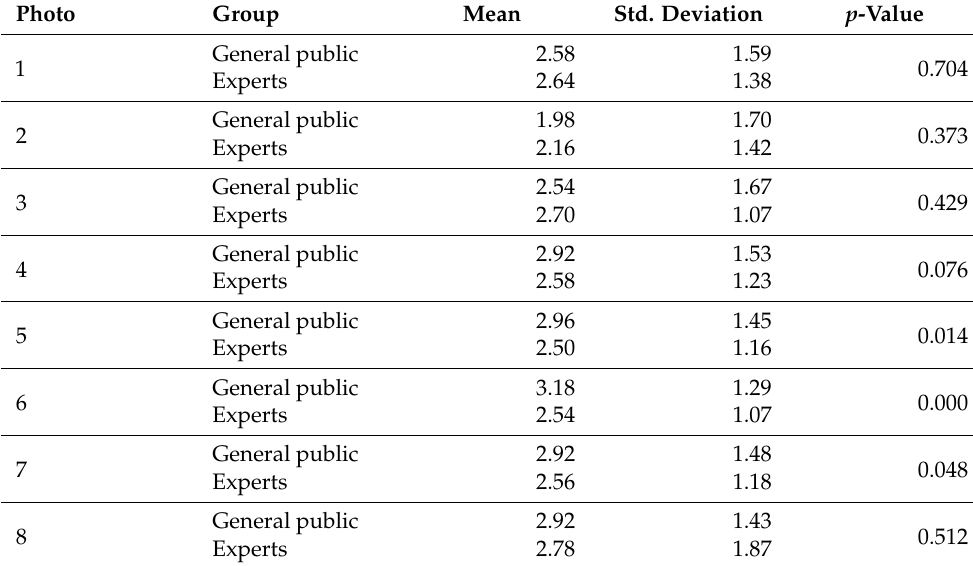
Table 12. Evaluation of wind turbine blade movement by experts and the